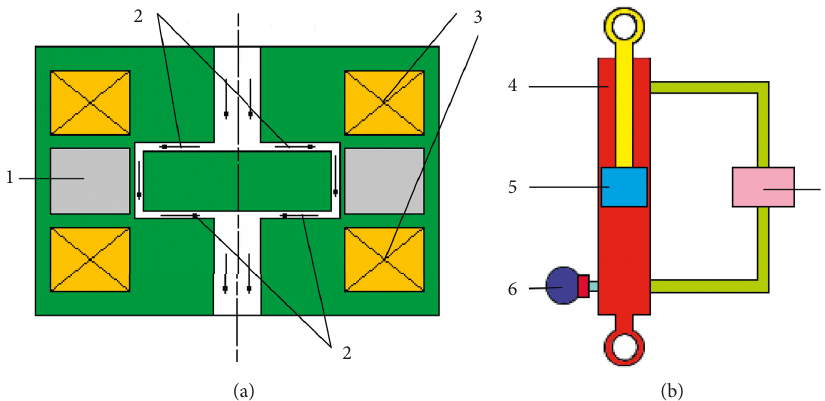
Figure 32: (a) Schematic of the two-way MR fluid damper. (b) Schematic view of the MR valve with the permanent-electromagnet system.1, permanent magnet; 2, MRF valves; 3, electromagnets; 4, damper; 5, piston; 6, accumulator; 7, two-way MR fluid valve